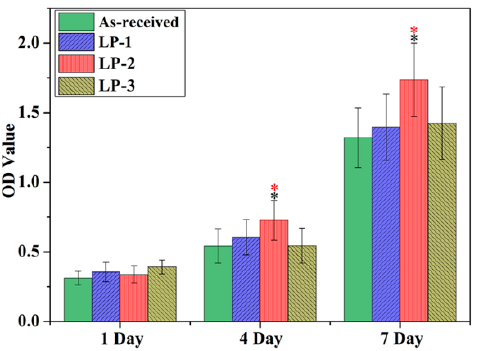
Figure 10. Cell proliferation evaluated via CCK-8 assay. NOTE: which is the meaning of: (Black * shows p < 0.05 vs. the as-received sample. Red * represents p < 0.05 vs. two other LP groups). Table 3. ANOVA analysis of cell proliferation evaluated via CCK-8 assay.